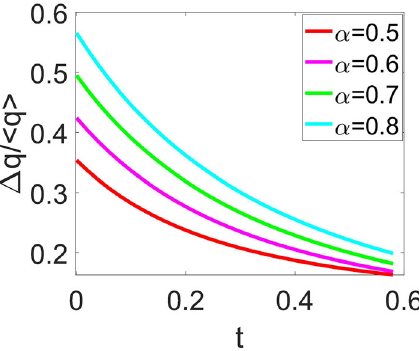
Fig. 30 Variations in the relative quantum fluctuation. The horizontal and vertical axes represent the time variable and relative fluctuation, respectively. The parameters are taken as: V 0 = 40, Q 0 = 1, (cid:18) = 5